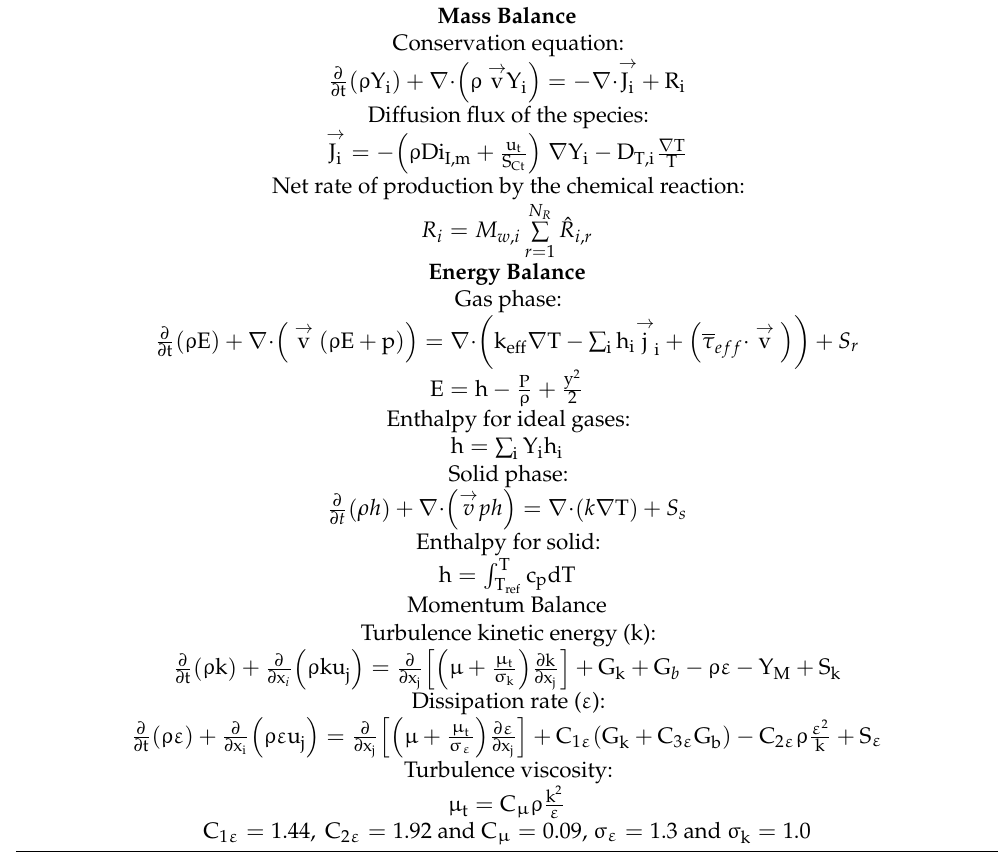
Table 2. Governing equations of the CFD